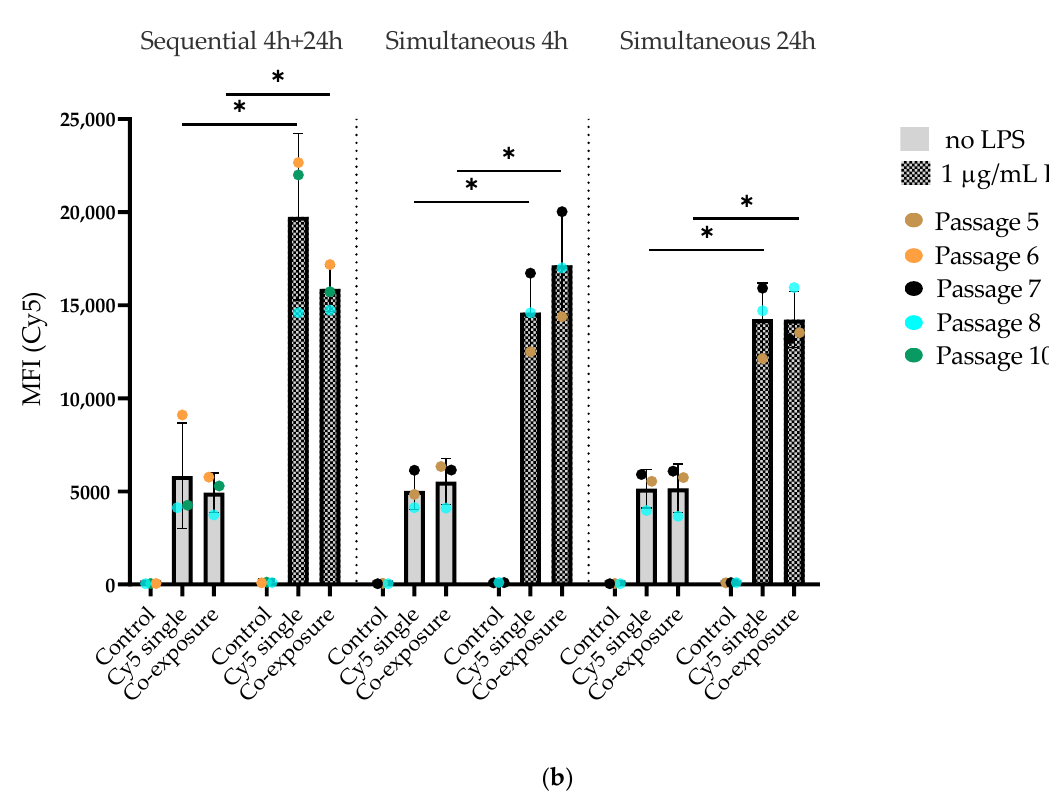
Figure 7. Flow cytometry data showing the uptake of SiO 2 particles in J774A.1 macrophages. Cells were prestimulated with 1- µ g / mL LPS for 24 h and then exposed to a single particle type or a combination of 59-nm SiO 2 -BDP FL and 920-nm SiO 2 -Cy5 particles. For comparison, we used unstimulated cells exposed only to SiO 2 particles in the same manner. The particles were administered sequentially or simultaneously for di ff erent time points (4 h and 24 h). ( a ) Median fluorescence intensity (MFI) of the BDP FL signal. ( b ) Median fluorescence intensity (MFI) of the Cy5 signal. Data show a significant increase (* p < 0.05) in the MFI of the BDP FL and Cy5 signals after LPS prestimulation. No significant di ff erence in the MFI was observed between the single- and co-exposure conditions. Control cells were stained with DAPI and were not exposed to SiO 2 particles.